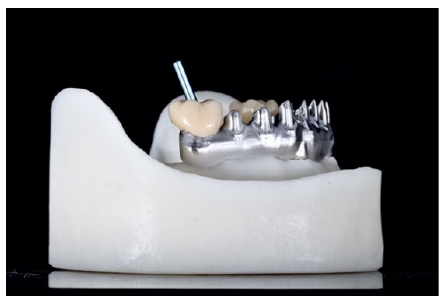
Figure 2. CAD/CAM Cr-Co Milled Framework.